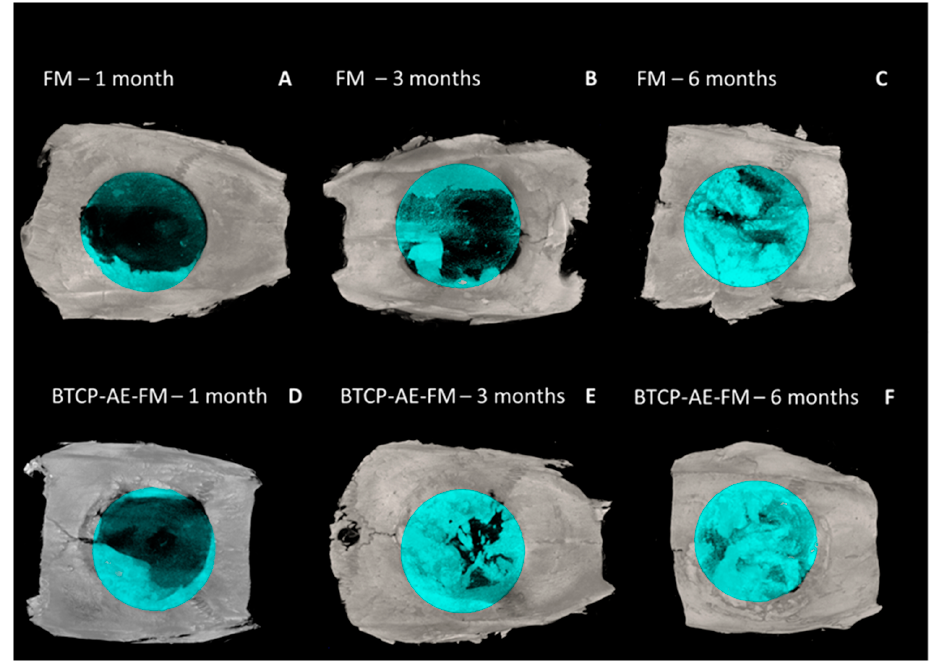
Figure 11. 3D surface-rendered micro-CT reconstructions (axial view) with blue-colored ROI mask (8 mm). ( A – C ) The FM and ( D – F) BTCP-AE-FM 1–3–6 months.